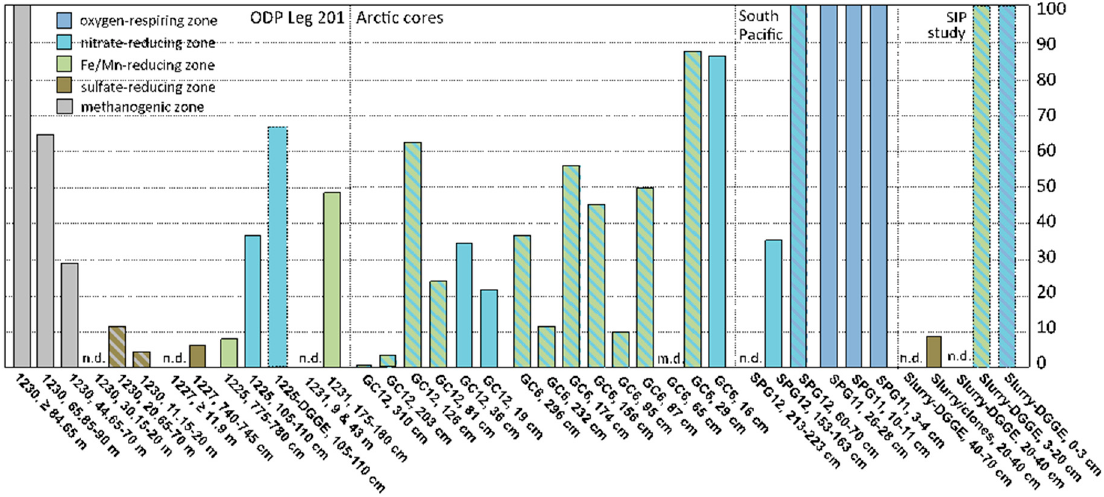
Figure 3. Bar diagram showing percentages of Marine Group I (MG-I) representation in archaeal 16S rRNA gene clone libraries, denaturant gradient gel electrophoresis (DGGE) and pyrosequencing profiles for marine sediment core samples, color-coded by electron acceptor availability. Color stripes indicate evidence for coexisting electron acceptors or pathways, or ambiguity in the data. Ocean Drilling Program (ODP) site numbers represent Equatorial Pacific Site 1225 [this study], Peru Margin Site 1227 [11], Peru Basin Site 1231 [3], and Peru Trench Site 1230 [11]. Arctic Ocean cores GC12 and GC6 from sediment cores near the hydrothermally active Gakkel Ridge were analyzed by 16S rRNA gene pyrosequencing [6]. SPG11 and SPG12 refer to South Pacific Gyre core SPG11 and South Pacific core SPG12 [4,5]. DGGE slurry data refer to DGGE results from stable carbon isotope probing experiments with sediments from the Severn Estuary, UK [48]. n.d., not detected; m.d., missing data. Data underlying this bar diagram are compiled in Table S1.